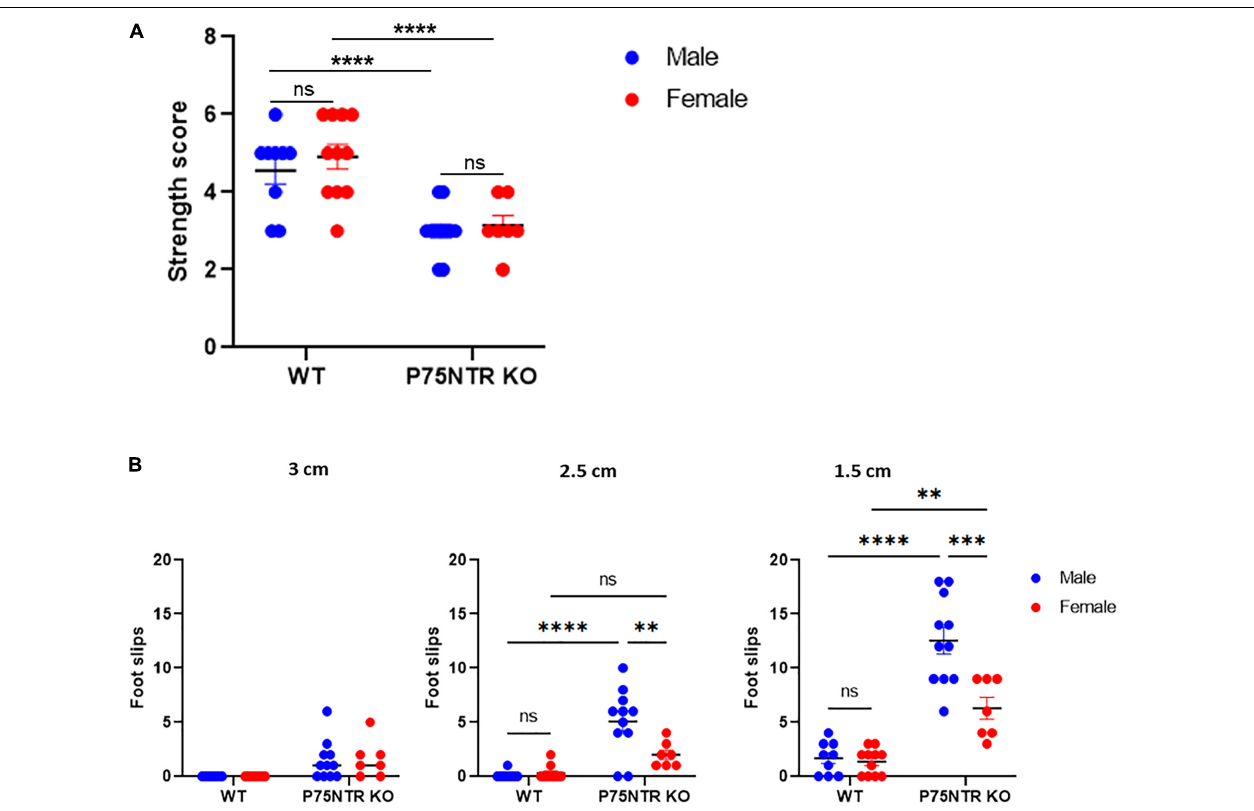
FIGURE 3 | Female and male p75NTR KO have similar strength defects, but females p75NTR KO showed better balance and coordination than males p75NTR KO on the beam balance test. (A) The strength of WT and p75NTR KO mice was tested using a weight test n : 9 WT male, 11 WT female, 12 p75NTR KO male, and 7 p75NTR female. ns; non-significant **** p < 0.0001 two-way ANOVA followed by Tukey Multiple comparison test. (B) A beam walking test using three different diameters (3, 2.5, and 1 cm) was used to test the balance and coordination of 9 WT males, 11 WT females, 11 p75NTR KO males, and 7 p75NTR KO females. The number of foot slips was scored. ns, non-significant. ** p < 0.01, *** p < 0.001, **** p < 0.0001 two-way ANOVA followed by Tukey Multiple comparison